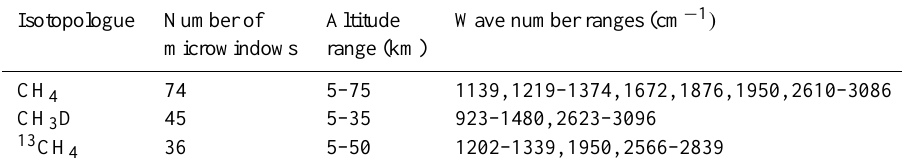
Table 1. Summary of microwindows used by ACE for retrieval of CH 4 .